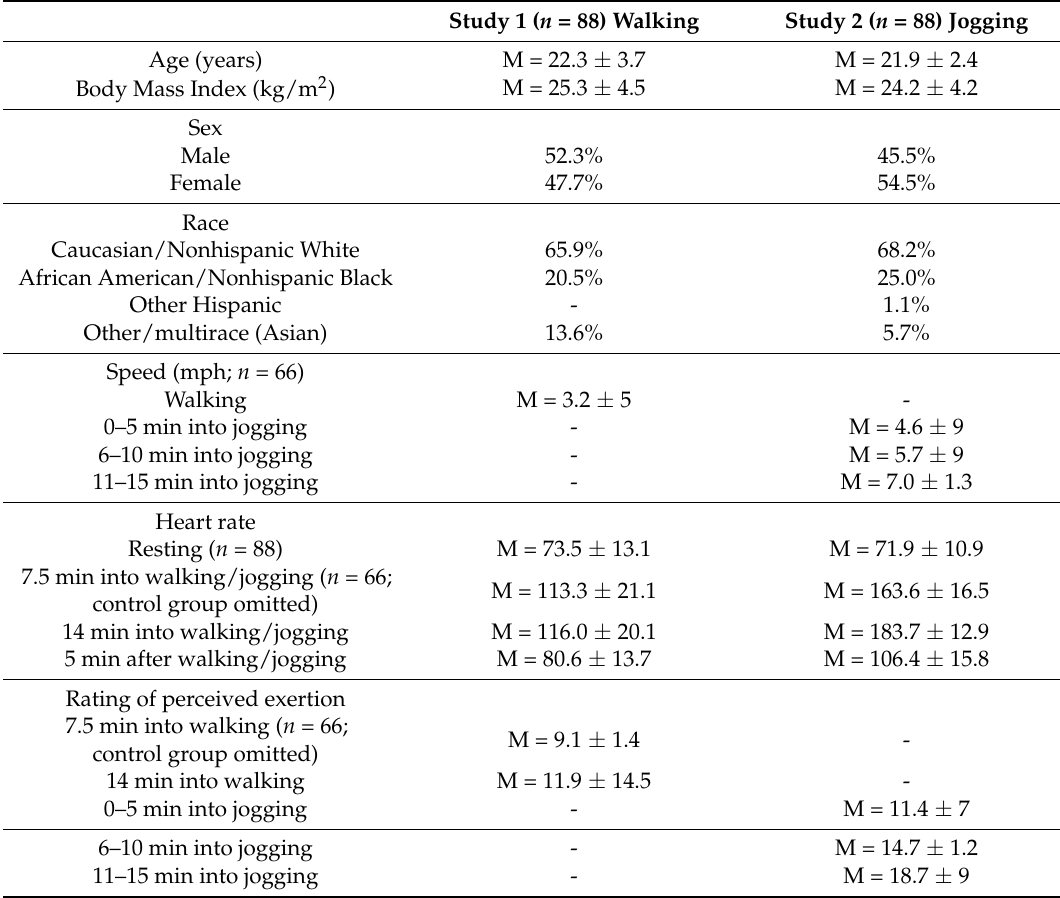
Table 1. Demographic characteristics between study 1 and study